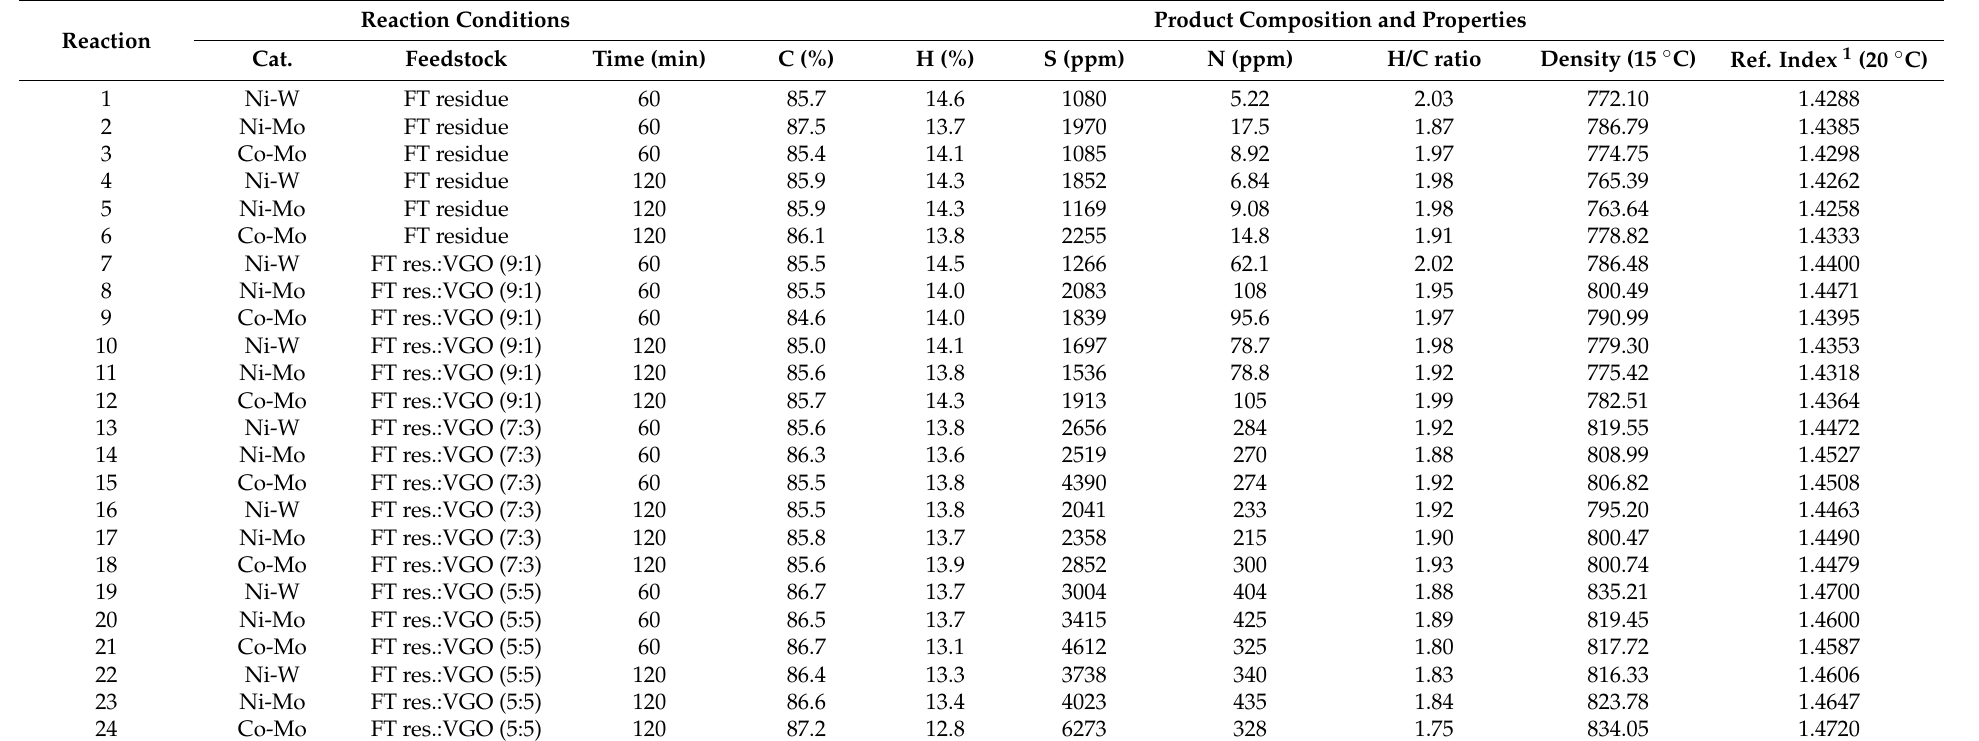
Table 2. Properties of the hydrocracking liquid products at different reaction